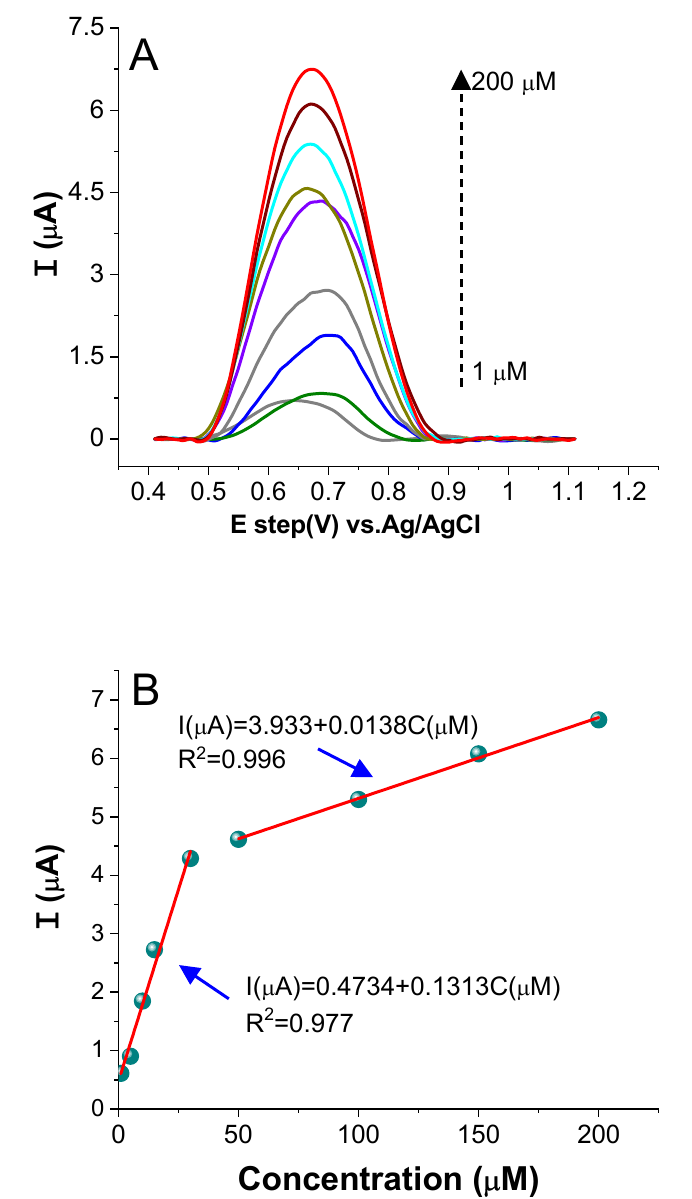
Figure 10. Effect of change of CR concentration on ( A ) SWV and ( B ) oxidation current signal in 0.1 M ABS solution at pH 6.5.